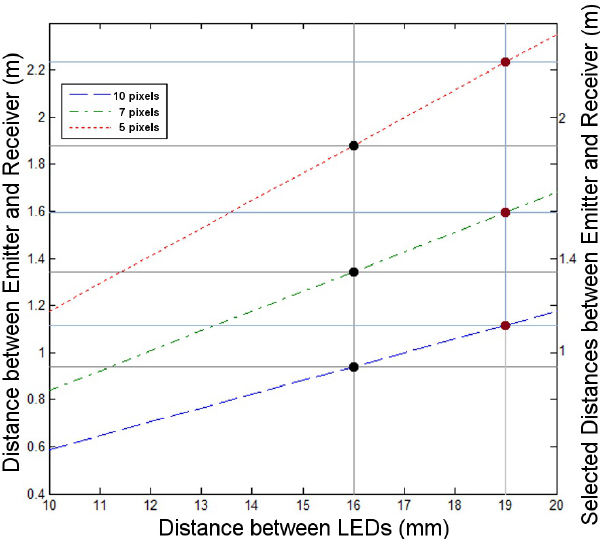
Figure 6. Distance between emitter and receiver for achieving a specific number of pixels (10, 7 and 5 pixels) in function of the LED separation. The distances of 0.016 m (black dots) and 0.019 m (red dots) represent the horizontal and vertical separation of the RGB LEDs in the testbed board respectively. The values in the right were the selected ones for each specific pixel number.